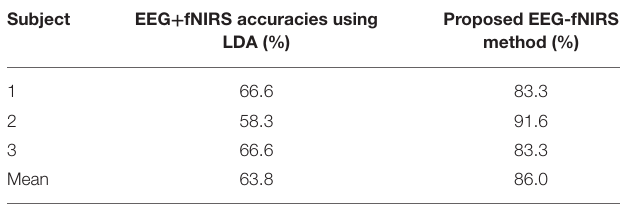
TABLE 3 | Accuracies obtained using the proposed